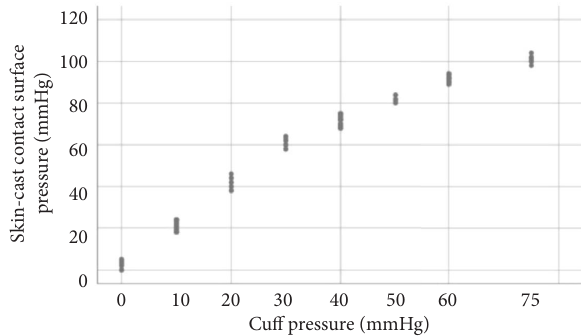
Figure 4: Graph showing the range of skin-cast contact surface pressure values (mmHg) relative to the cuf pressure values (mmHg).